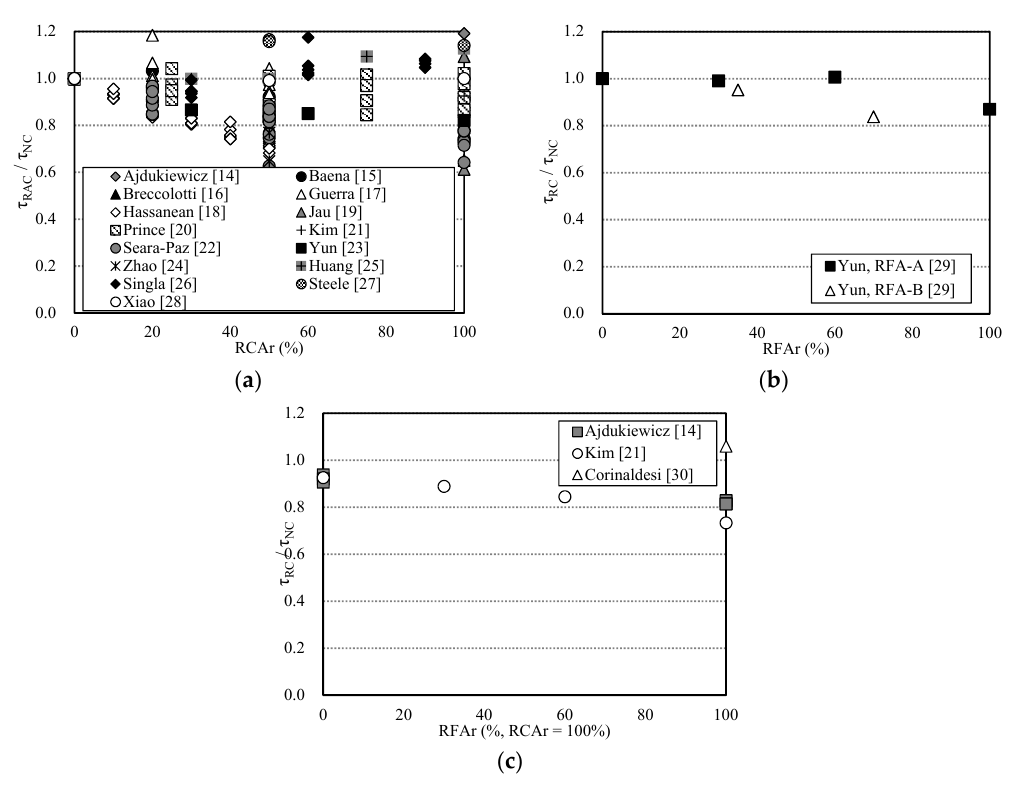
Figure 1. Comparison of bond strength ratio ( τ RAC / τ NC ) with recycled aggregate. ( a ) Recycled coarse aggregate (RCA) concrete; ( b ) Recycled fine aggregate (RFA) concrete; ( c ) Both recycled fine and coarse aggregate (RFCA) concrete.